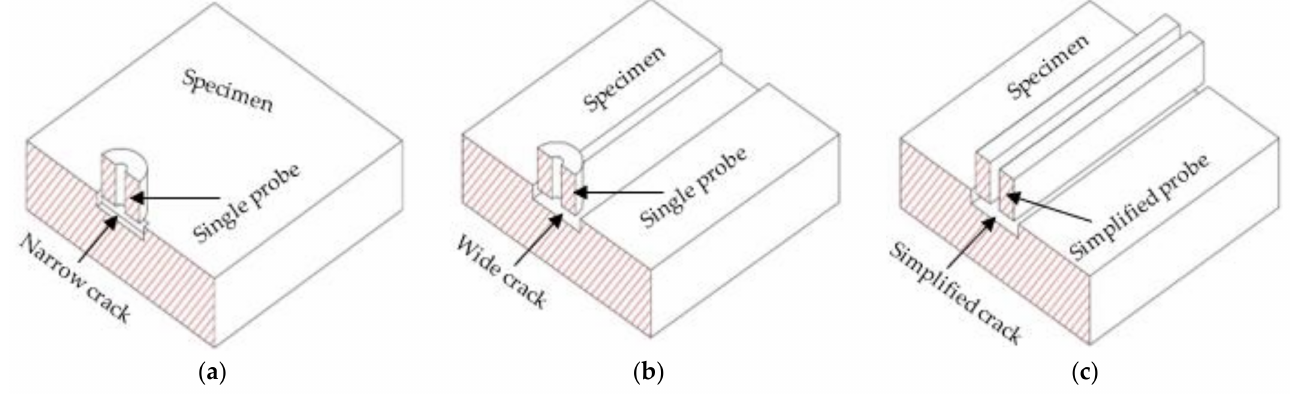
Figure 6. Same section views with ( a ) 3D configuration, ( b ) 3D configuration with long defect, and